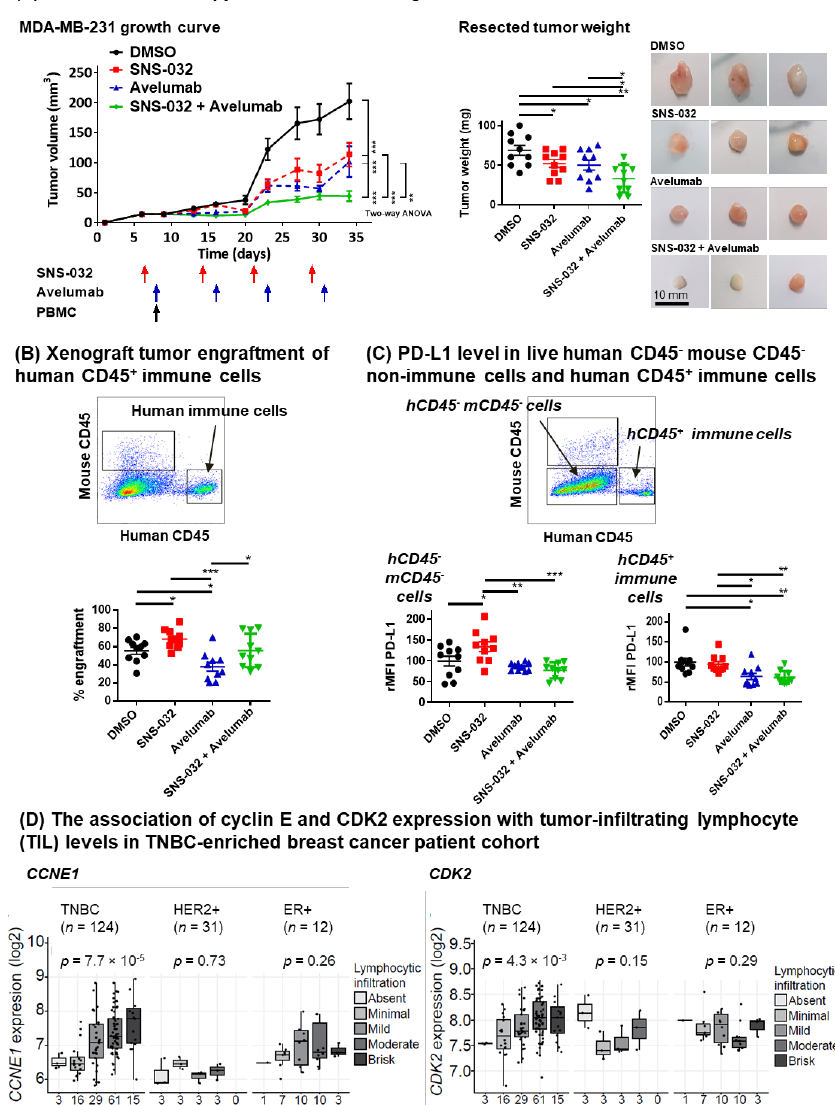
Figure 5. Combination treatment of SNS-032 with anti-PD-L1 avelumab antibody. ( A ) Tumor growth measurements following inoculation ( left ), resected tumor weights ( middle ) and representative tumor photographs ( right ) of MDA-MB-231 tumors of the partly immuno-humanized mice treated with DMSO, SNS-032 inhibitor alone, avelumab antibody alone, or with sequential dosing with SNS-032 and avelumab ( n = 10 mice per condition). Once palpable tumors were formed, mice received an intravenous injection of SNS-032 (15 mg/kg) (on Day 6), followed by avelumab (10 mg/kg) pre-mixed with a single dose of human healthy volunteer PBMC to provide effector cells (on Day 9). Subsequent inhibitor doses (Day 13, 20, 27) and antibody doses (Day 16, 23, 30) were given weekly. ( B ) Human immune cell engraftment in mouse tissues (% engraftment) was calculated using the formula: human CD45 + cells/(human CD45 + cells + mouse CD45 + cells) × 100%. ( C ) PD-L1 expression levels of live non-immune cells (human and mouse CD45 − cells) ( left ) and live human CD45 + immune cells ( right ) were measured by flow cytometry with anti-human CD274 staining of extracted xenograft tumors. All p -values were reported with the following associated symbols: p < 0.05 (*), p < 0.005 (**), p < 0.0005 (***), and all tests were two-sided. ( D ) CIBERSORT was used for the immune cell analysis of the Guy’s cohort gene expression data. Lymphocytic infiltration levels were classified into five groups: absent, minimal, mild, moderate and brisk. Numbers of patients per group are indicated below the graphs. p -values were determined using Mann–Whitney U test for the CIBERSORT